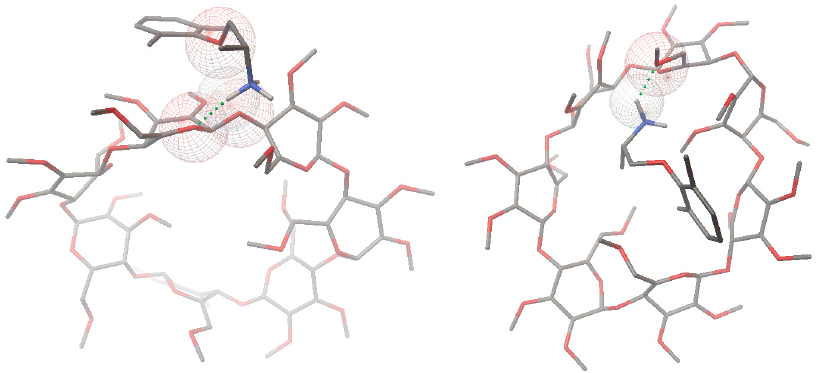
Figure 5. Three-dimensional models of the R -MXL-CD ( left ) and S -MXL-CD ( right ) complexes with the highest binding energy (Green dots show the hydrogen bonds. Spheres mark the participating atoms. Grey is carbon, red is oxygen, and dark blue is nitrogen).